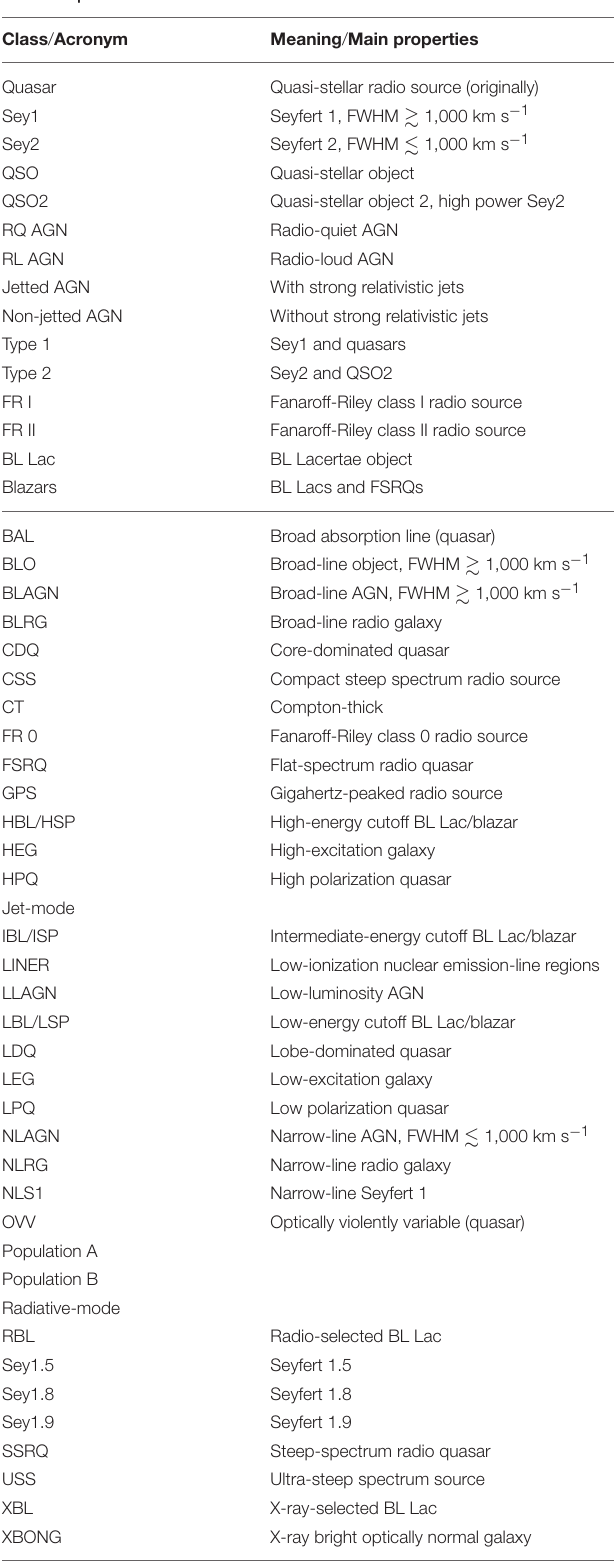
TABLE 1 | The AGN zoo: list of AGN classes.